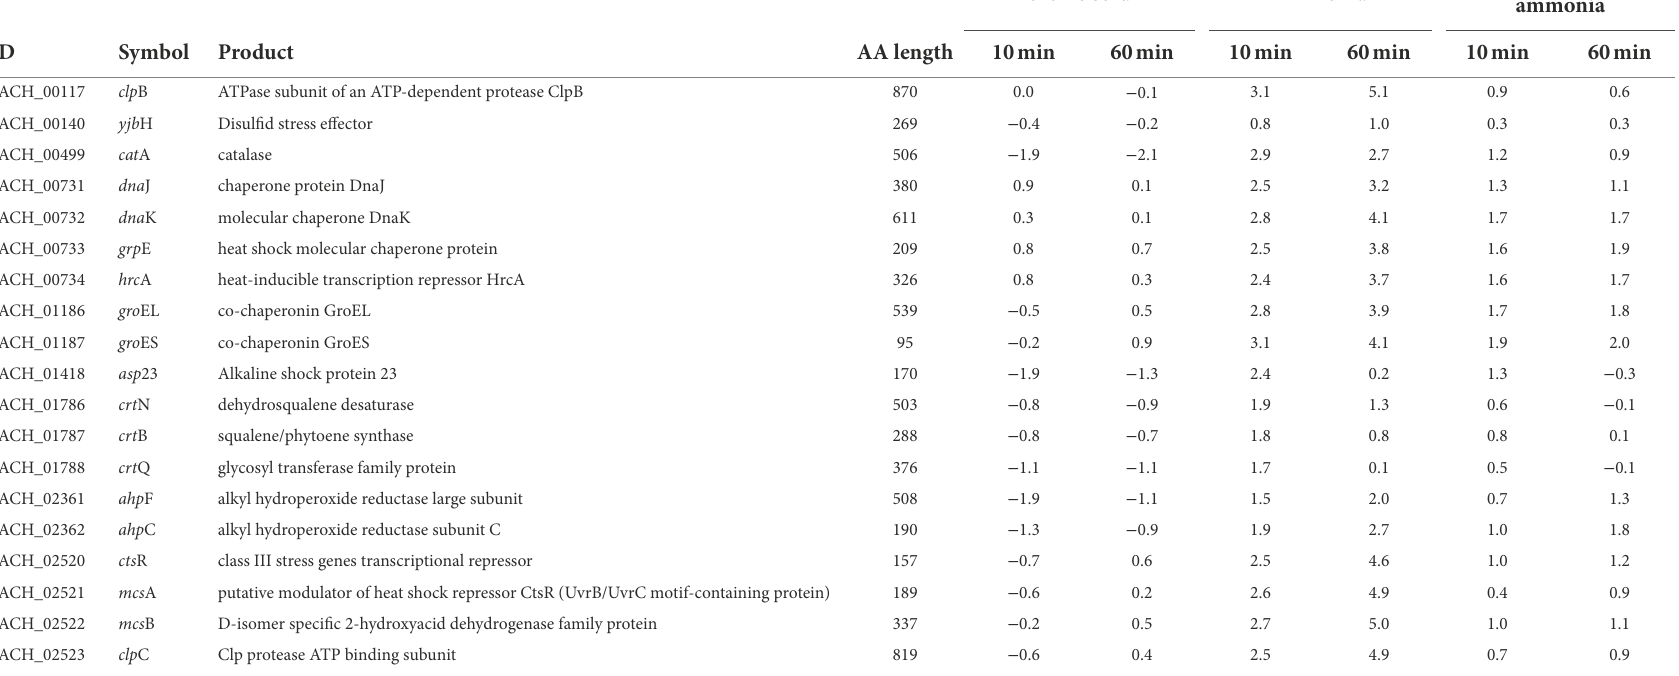
Gene transcription (log2FC) compared to unchallenged control samples Porcine serum & Porcine serum Ammonia